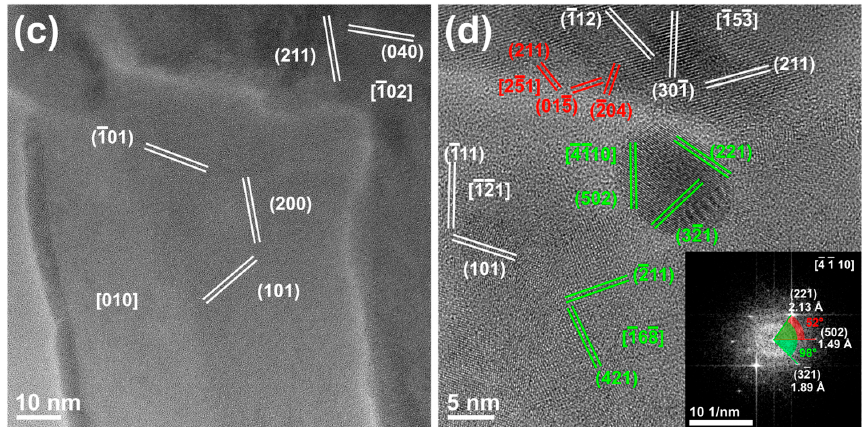
Figure 4. In situ HRTEM heating experiment of micron-sized TANs: ( a , b ) Evolution of the small aggregates of TANs reported in Figures 2 and 3, now recorded at 500 °C. The white dotted rectangles indicate the regions of interest analyzed by HRTEM and reported in panels c and d ; ( c ) HRTEM image of a an extended crystal domain of rutile (in white) in the first aggregate (see the rectangle in panel 4 a ); ( d ) HRTEM image of region of the second aggregate with patched crystallization (see the rectangle in panel 4 b ). Distinct crystal domains of rutile (in white), brookite (in green) and anatase (in red) can be identified. The 2D-FFT of the brookite seed is presented in the inset, showing its interplanar distances and corresponding angular relationships for the observed zone axis.